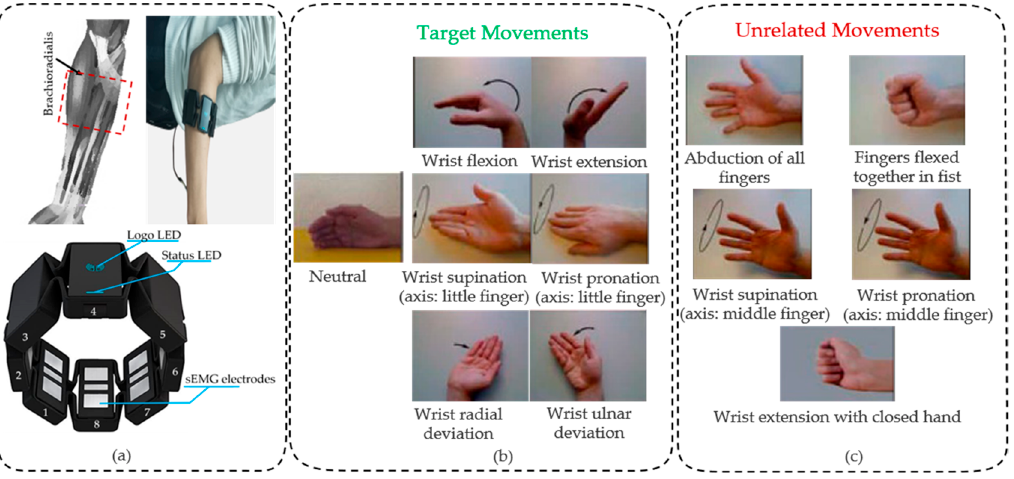
Figure 2. Experimental devices and data acquisition scheme: ( a ) Thalmic Myo armband and schematic diagram of the experimental data acquisition; ( b ) The seven target movements; ( c ) The five unrelated movements.